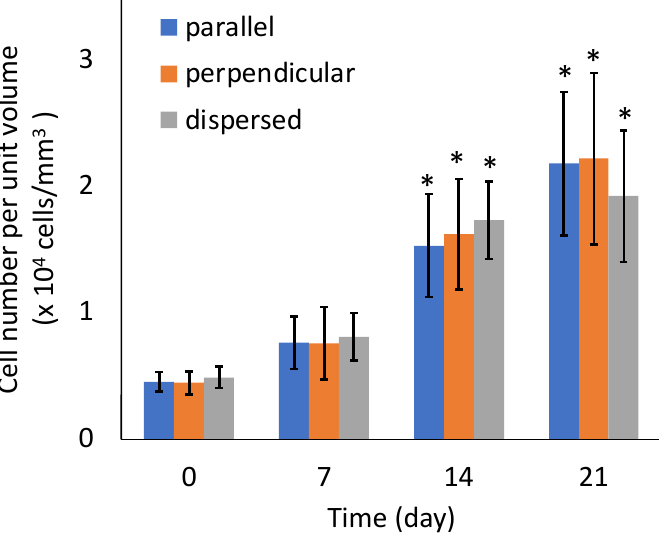
Figure 11. Sulfated GAG content of the agarose gel-sheet constructs cultured for 21 days. Mean +/−